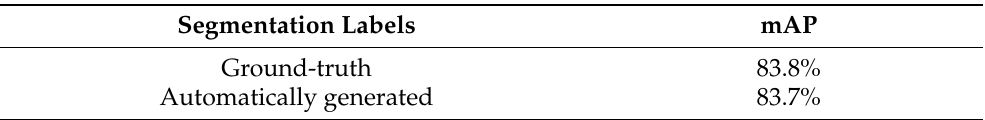
Table 5. The mAP for the ground-truth segmentation labels and the automatically generated segmen- tation